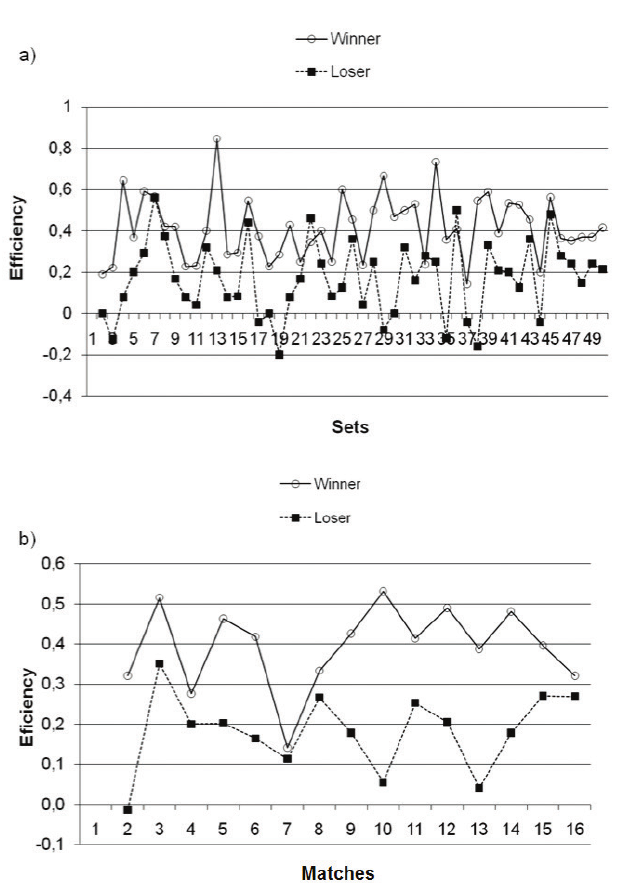
Figure 2. Efficiency in Transition I of the winner and loser teams in each set (a); efficiency in Transition I of the winner and loser teams in each game